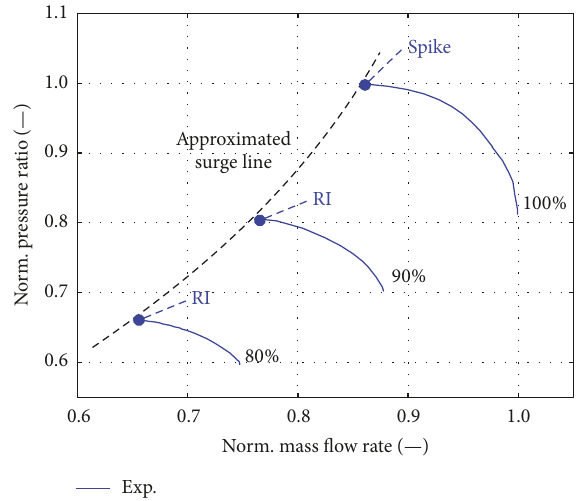
Figure 2: Experimental results for total pressure ratio at part and nominal rotation